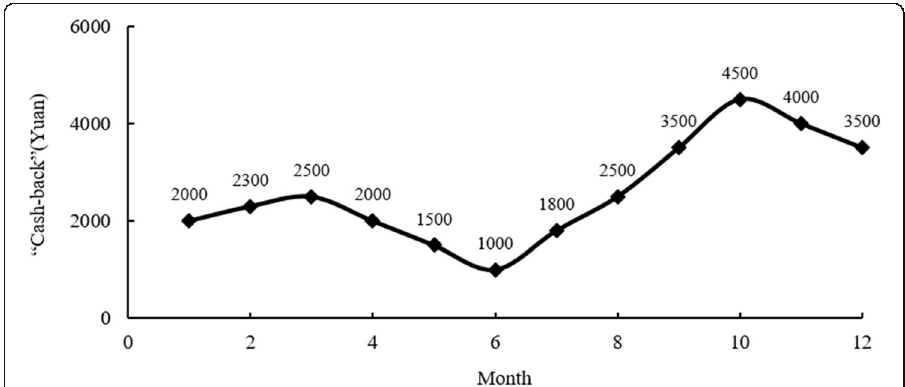
Fig. 2 “ Cashback ” seasonal fluctuations. The amount of “ cashback ” is roughly the monthly average, and